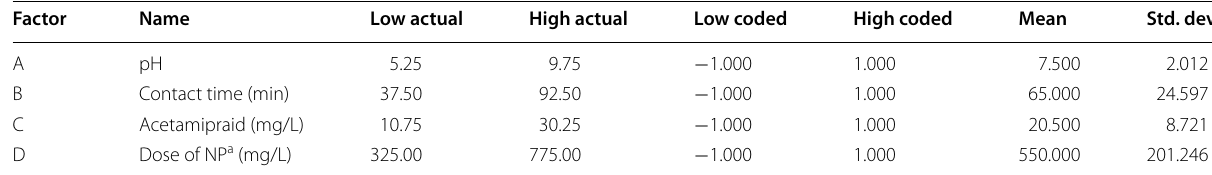
Table 1 The levels and ranges of variables central composite statistical experiment